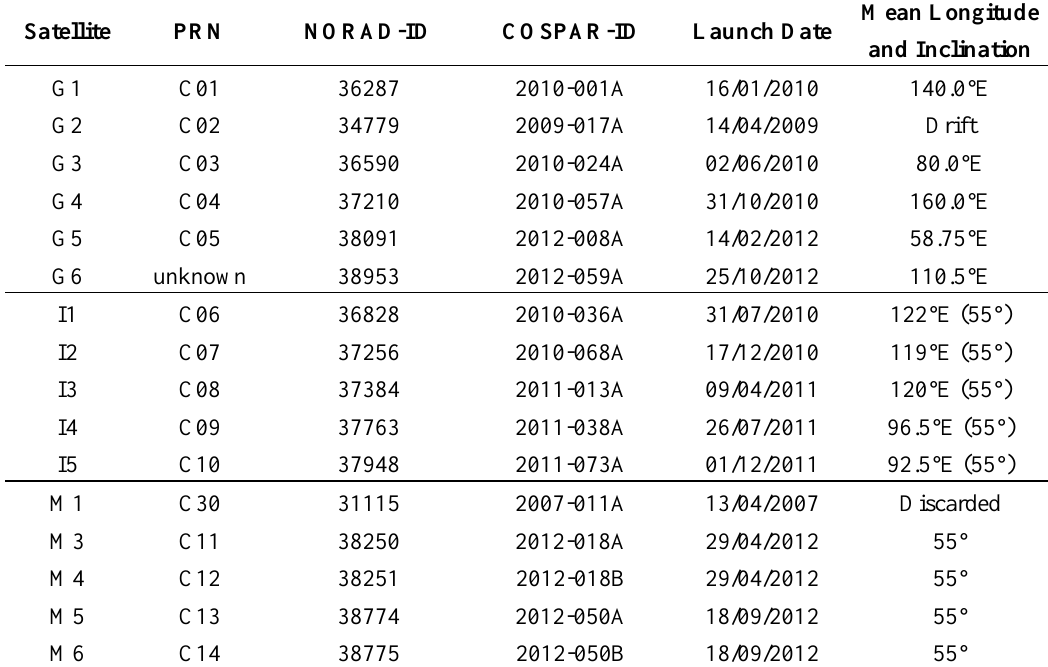
Table 1. Satellites of the current BeiDou